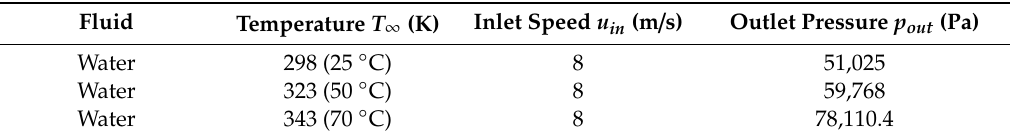
Table 1. Parameter setting at di ff erent